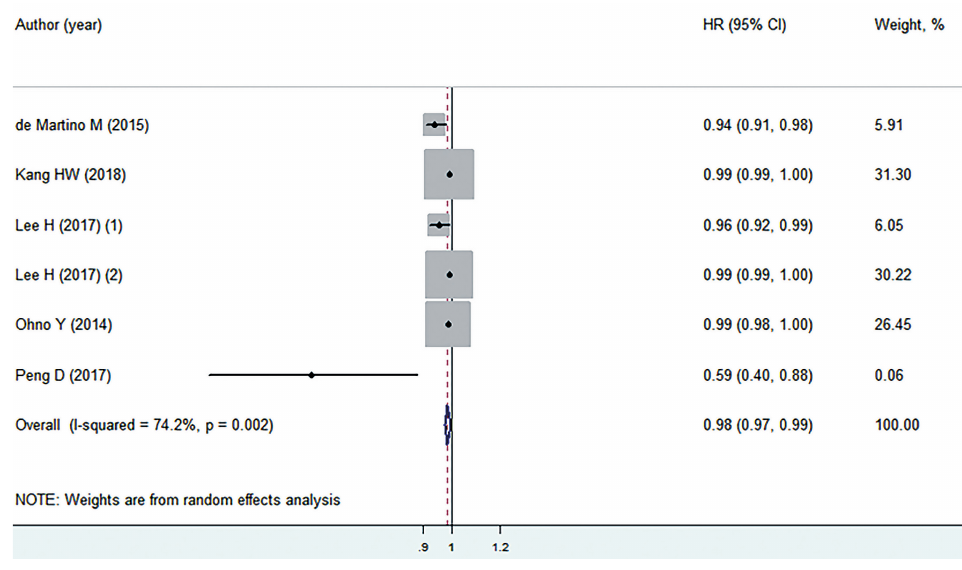
Figure 3 - Preoperative serum TC levels and CSS in patients with surgically treated